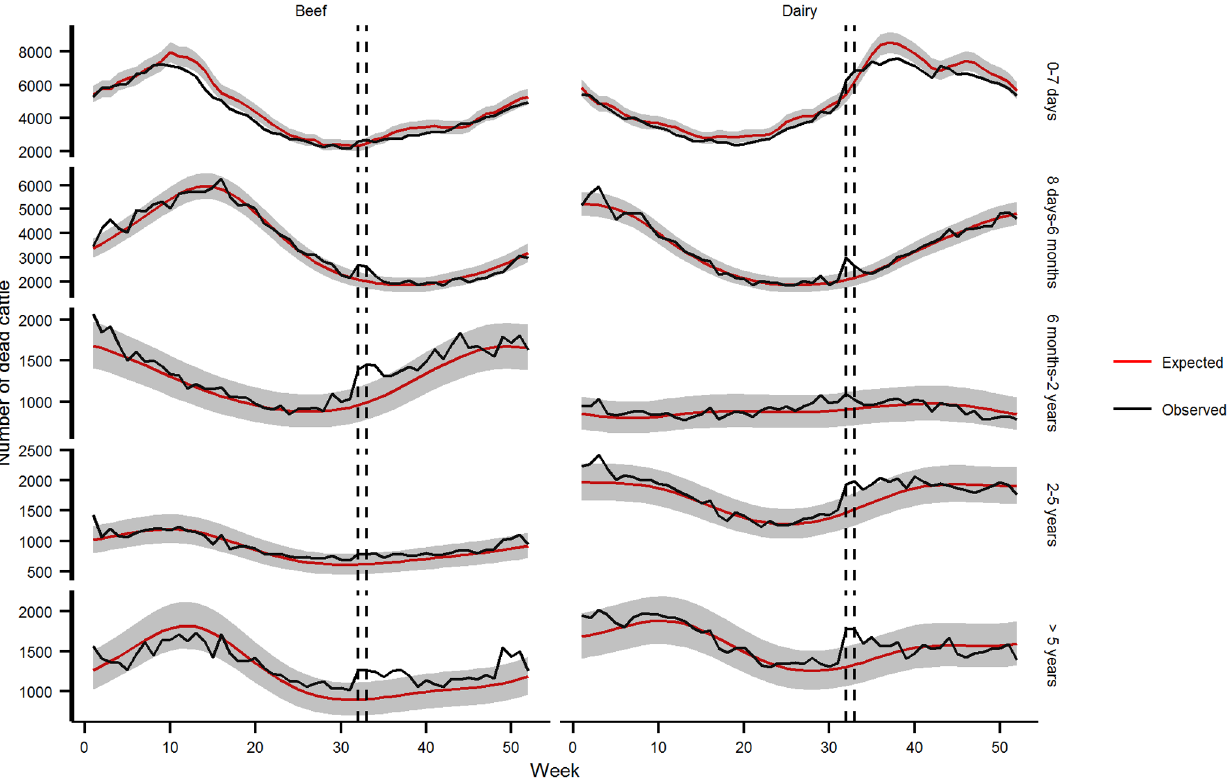
Figure 2. Comparison of observed and expected weekly cattle mortality in France in 2003 by age and production type. Dashed lines indicate the heat wave period. Expected mortality is represented by the red line (with the 99% confidence interval in gray), and observed mortality by the dark line.